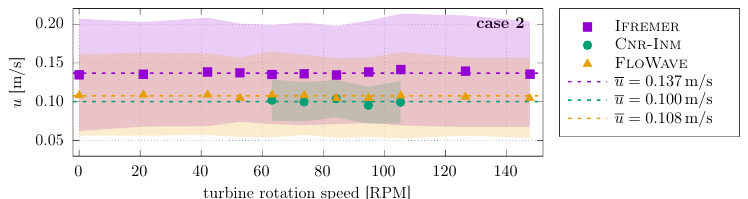
Figure 10. Variation of the time-averaged (markers) and standard deviation (shading) of the horizon- tal wave orbital velocity u with rotational speed for case 2 at all facilities, obtained with the ADV. Dashed lines are the average of horizontal wave orbital for case 2 at all rotational speed settings per